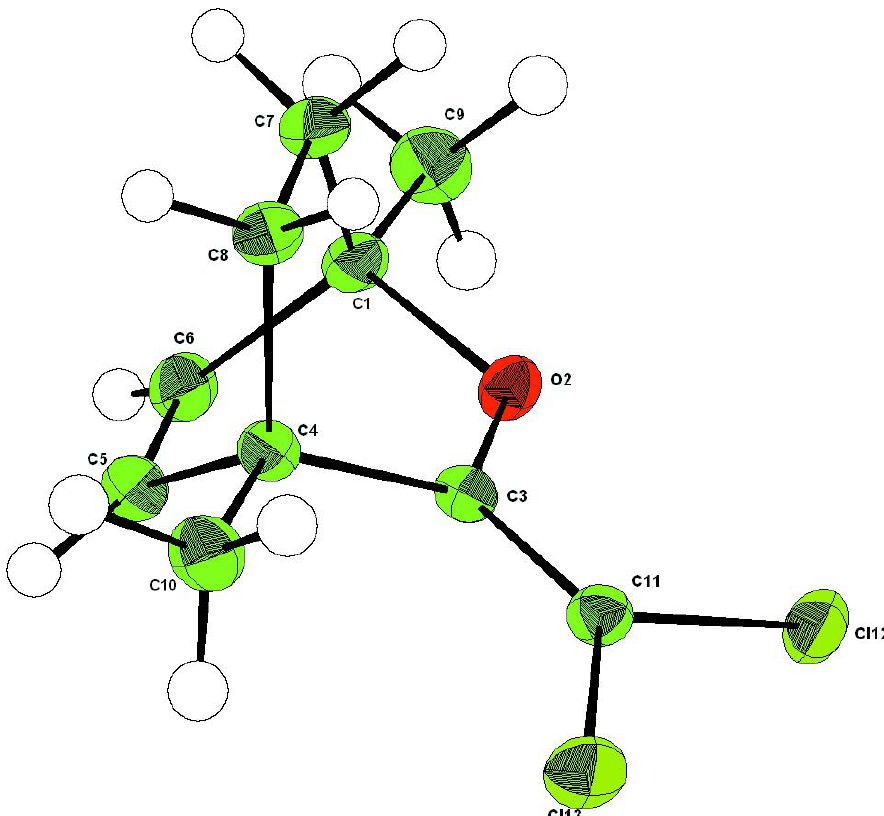
Figure 1 The title compound with displacement ellipsoids drawn at the 50% probability level. H atoms are shown as spheres of arbitary